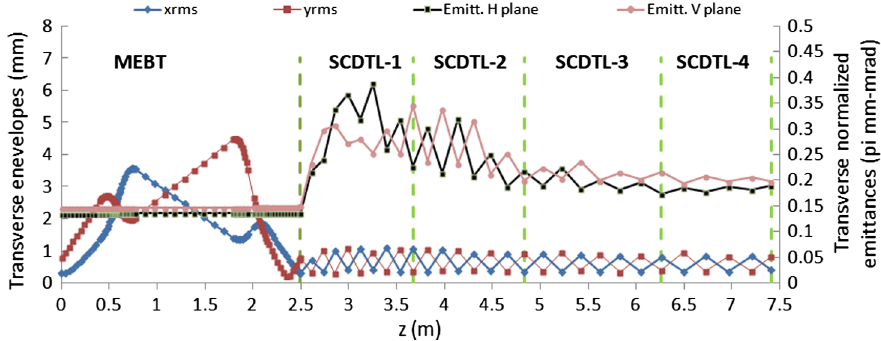
FIG. 6. Computed rms transverse envelopes and emittances from the injector exit up to the SCDTL-4 output.